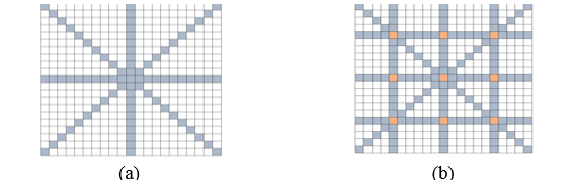
Figure (2). Directional scanlines for minimum point selection (a) MSD approach and (b) NGPs approach.